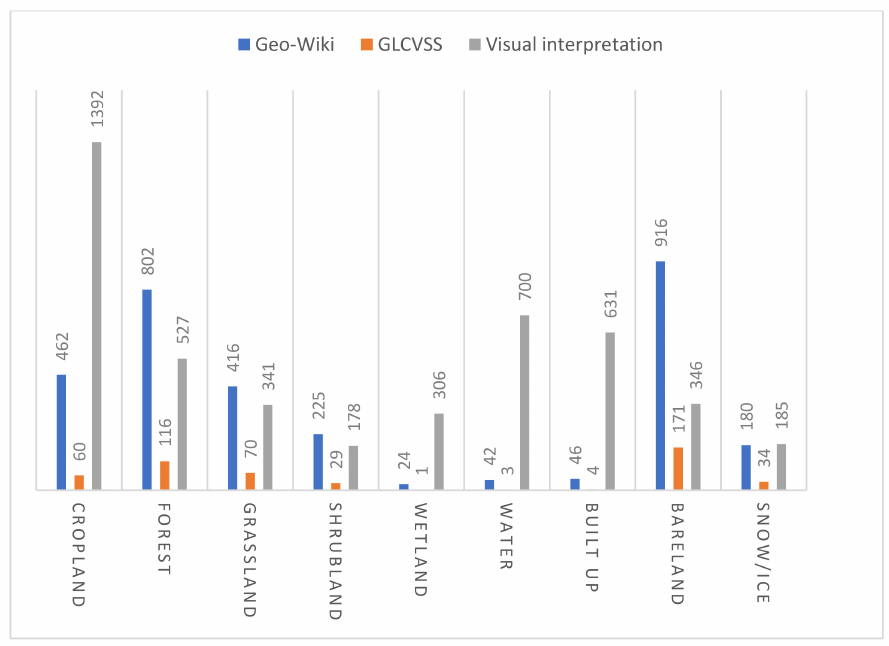
Figure 5. Statistical distribution of the number of different types of samples in the three independent validation sample sets.